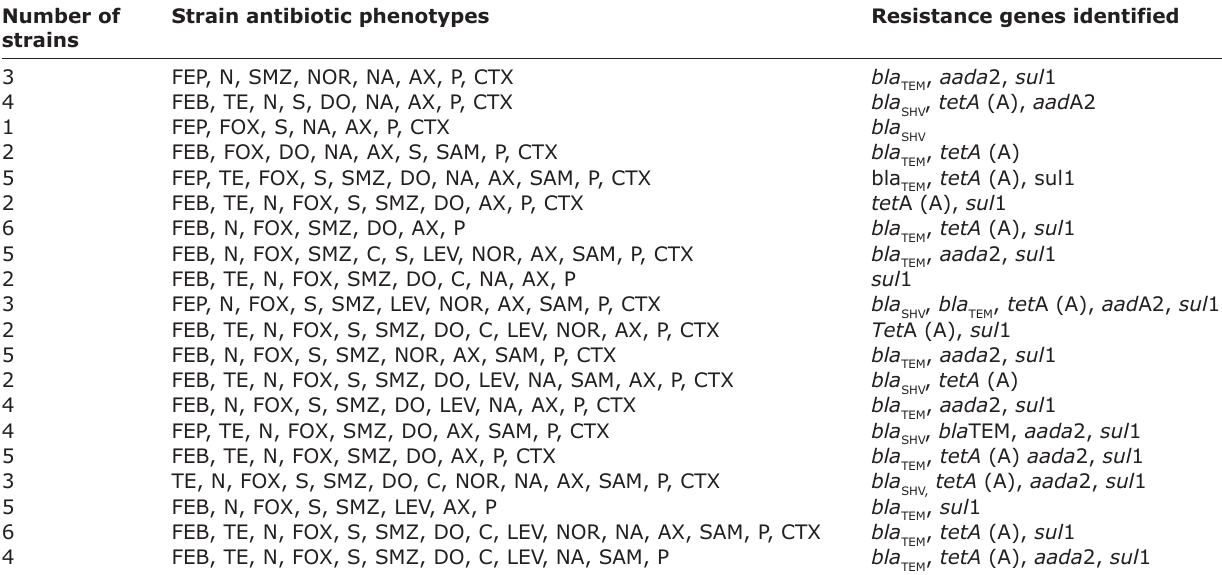
Table-4: Antimicrobial resistance patterns and resistance genes profiles of E. coli strains. Number of Strain antibiotic strains